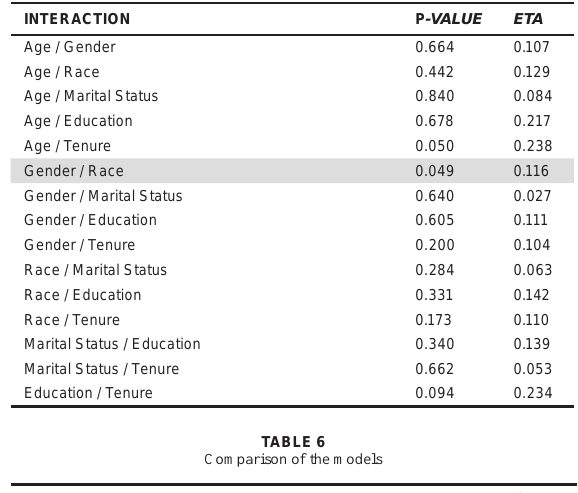
tABLe 5 Summary of two-way ANOVA